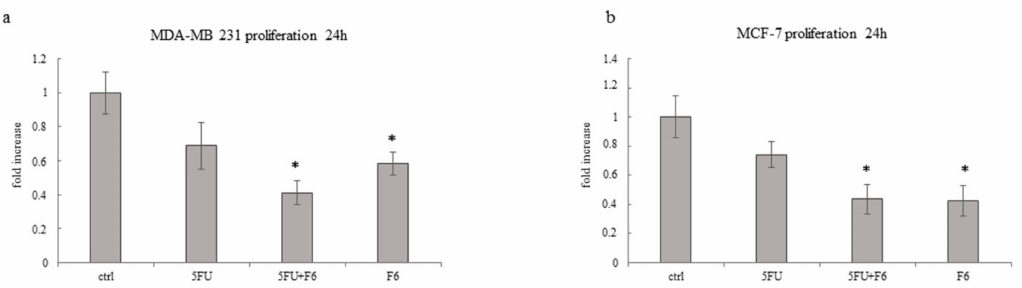
Figure 2. E ff ect of 5FU, 5FU + F6, and F6 on proliferation of MDA-MB-231 ( a ) and MCF-7 ( b ) cells. Cell proliferation was determined after 24 h of treatment by cell count assays performed by a particle count and size analyzer. Values, expressed as fold increase of control value considered as 1, are means of three independent experiments performed in triplicate, with SD represented by vertical bars. * p < 0.05 versus ctrl by ANOVA followed by Bonferroni